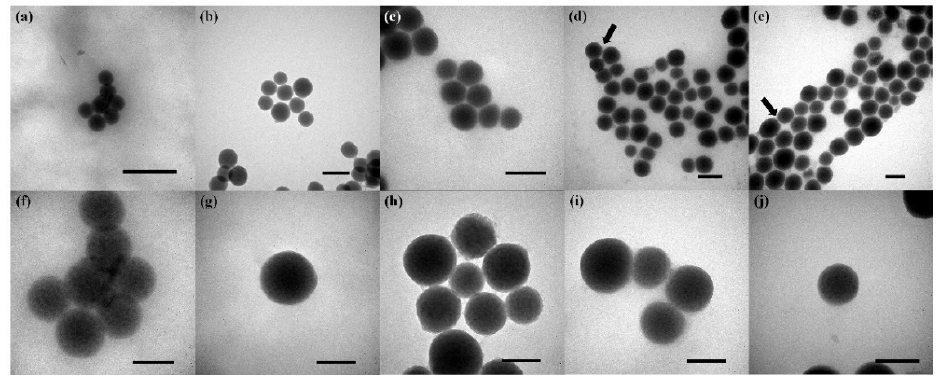
Figure 1. Bright field TEM images of synthesized particles ( a ) 0Zn-BAGNPs, ( b ) 0.5Zn-BAGNPs, ( c ) 1.0Zn-BAGNPs, ( d ) 1.5Zn-BAGNPs, and ( e ) 2.0Zn-BAGNPs, before washing with 1 M nitric acid, ( f ) 0Zn-BAGNPs, ( g ) 0.5Zn-BAGNPs, ( h ) 1.0Zn-BAGNPs, ( i ) 1.5Zn-BAGNPs, and ( j ) 2.0Zn-BAGNPs, after washing with 1 M nitric acid (operating at 100 kV), Scale bars = 200 nm.